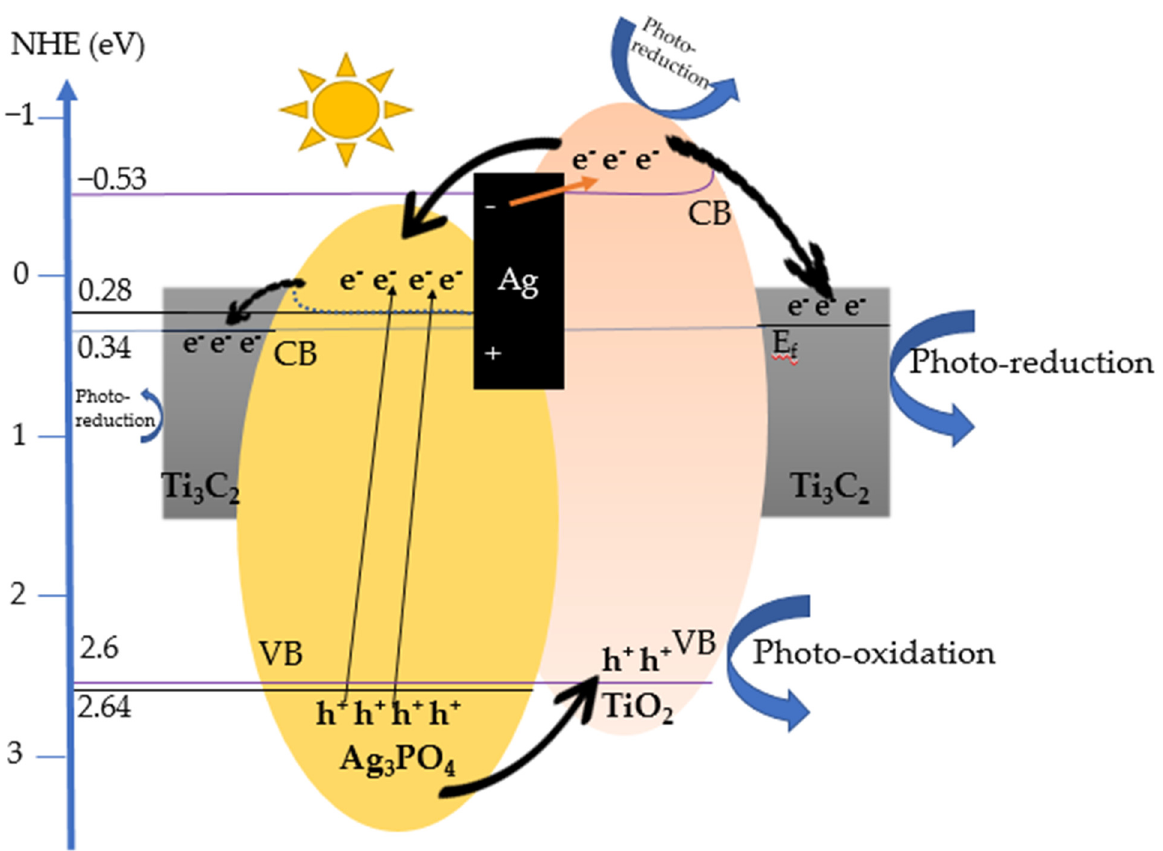
Figure 10. A schematic illustration of the proposed photocatalytic mechanism of Ag 3 PO 4 /TiO 2@ Ti 3 C 2 (A4) exposed to solar light. (A4) exposed to solar